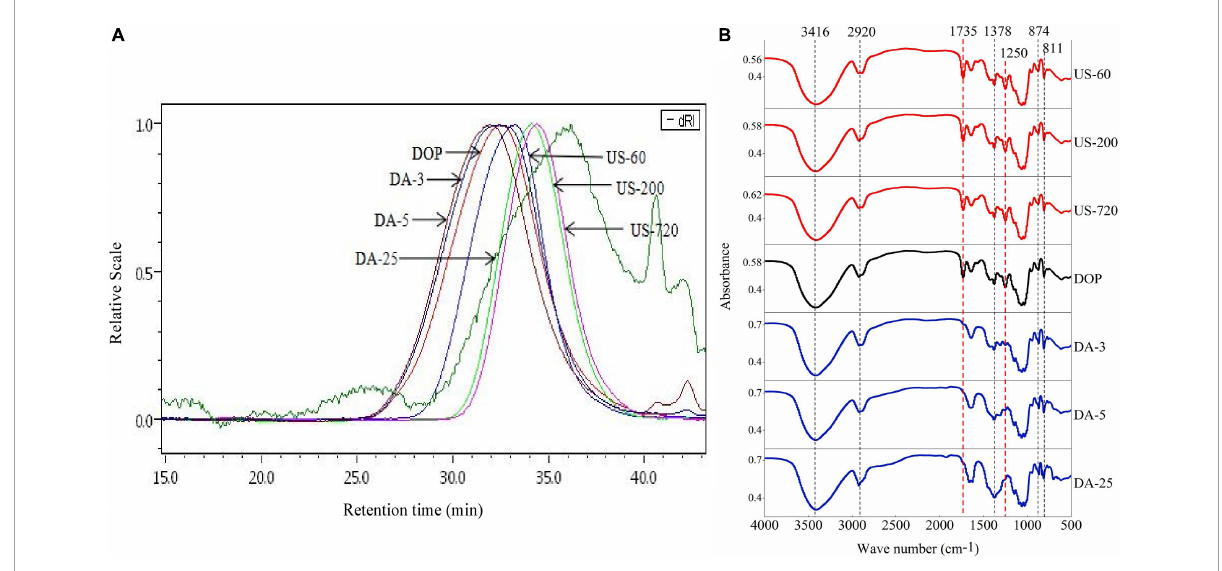
FIGURE1 HPSEC elution profiles (A) and Infrared spectra (B) of the native and modified